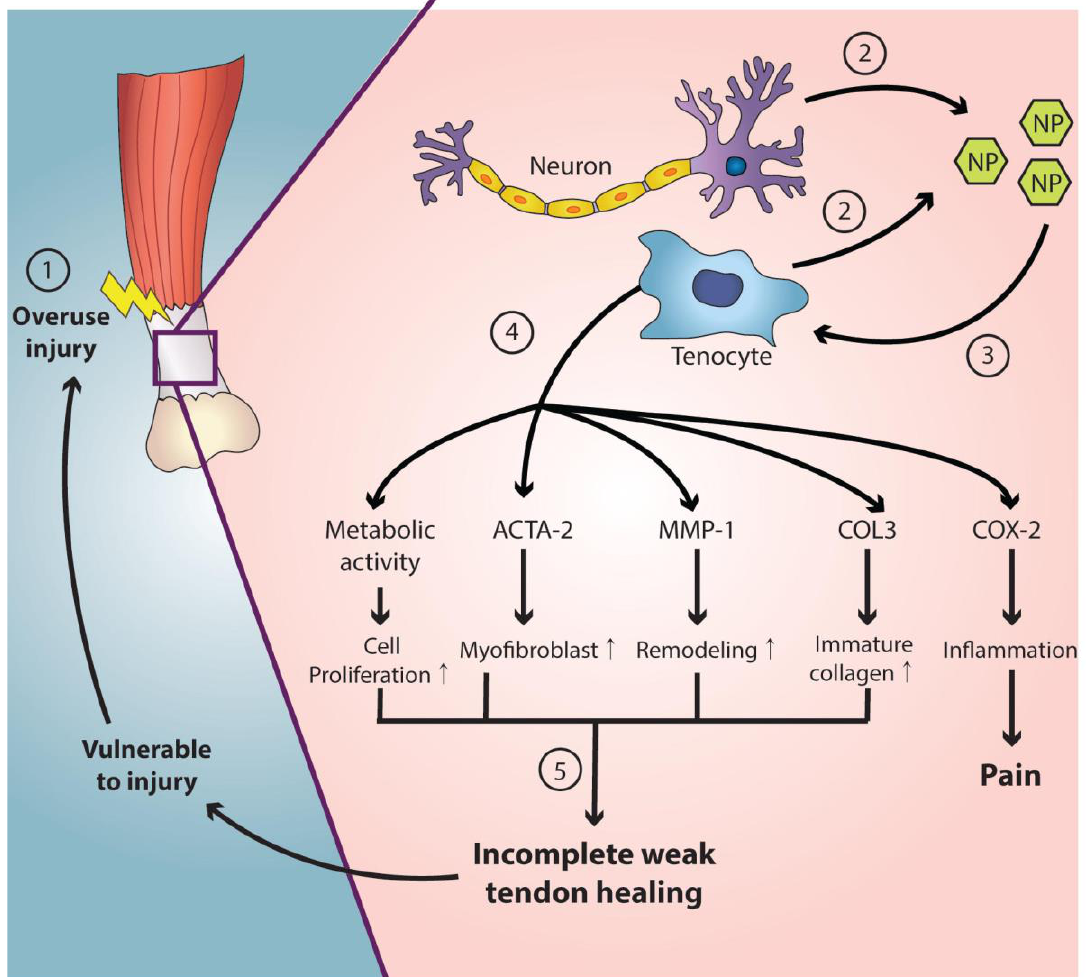
Figure 1. The etiology of tendinopathy. (1) The overuse (repetitive or excessive loading) and de- creased local vascular perfusion are the acquired local factors [5]. (2, 3) Tenocytes produce signal substances including substance P, glutamate, catecholamines, and acetylcholine [47,48]. (4) Hyper- cellularity, fibrogenic response, expression of matrix metalloproteinases, production of abnormal amounts of collagen type III, and the inflammatory process contribute to the pathogenesis of tendinopathy. (5) If tendon healing is incomplete, the tendon becomes vulnerable to further injury. NP neuropeptide; ACTA-2 actin alpha 2; MMP-1 matrix metalloproteinase-1; COL3 collagen type III; COX-2 cyclooxygenase-2.